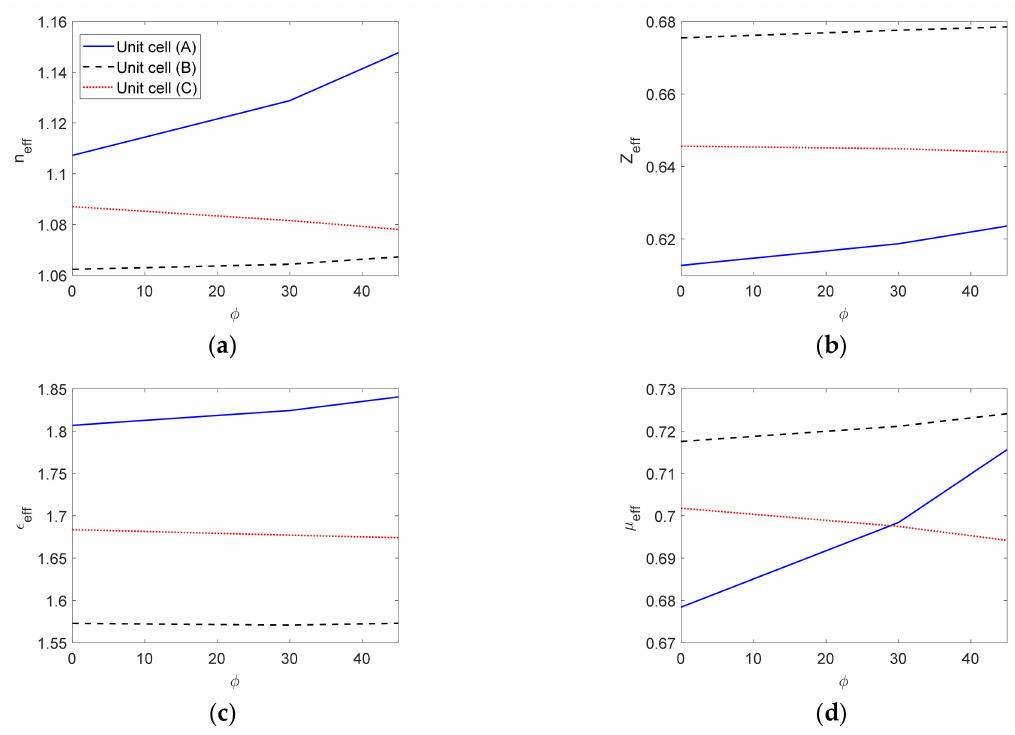
Figure 9. Effective EM parameters versus φ for the unit-cells A , B , and C . ( a ) The effective refractive index, ( b ) the effective wave impedance, ( c ) the effective permittivity, and ( d ) the effective permeability.